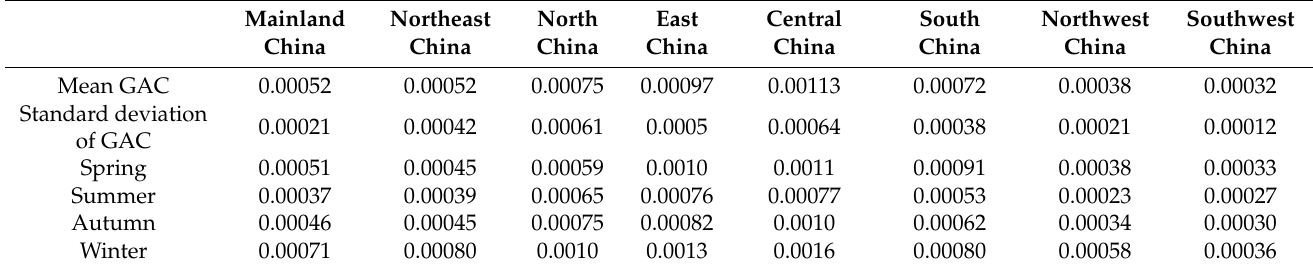
Table 5. Summary of the simulated GAC (m − 1 ) for mainland China and its subregions.